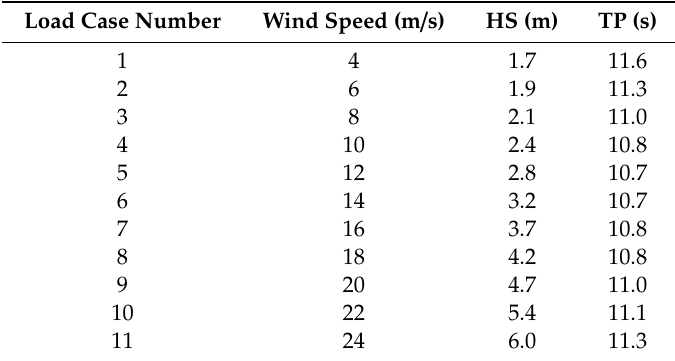
Table 2. Load cases [42].